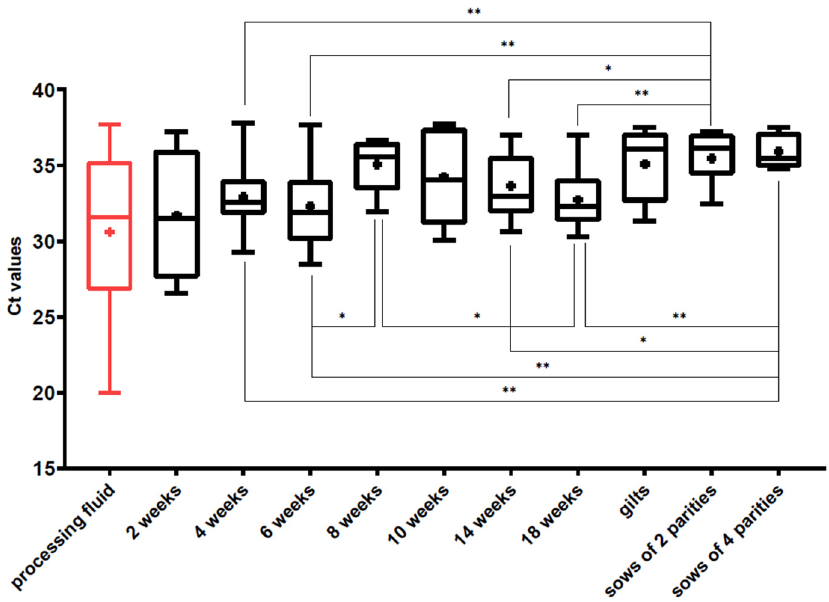
Figure 4. Boxplots representing the Ct values of the PCV3-positive processing fluids and serum sample pools of different age groups. The whiskers show the minimum and the maximum, and the “+” signs represent the average. The horizontal lines of the box show the first quartile, the median and the third quartile. The statistical comparison of the Ct values was performed using the Mann–Whitney test. The asterisks above the boxes represent the statistically significant differences (*: p < 0.05; **: p < 0.01).